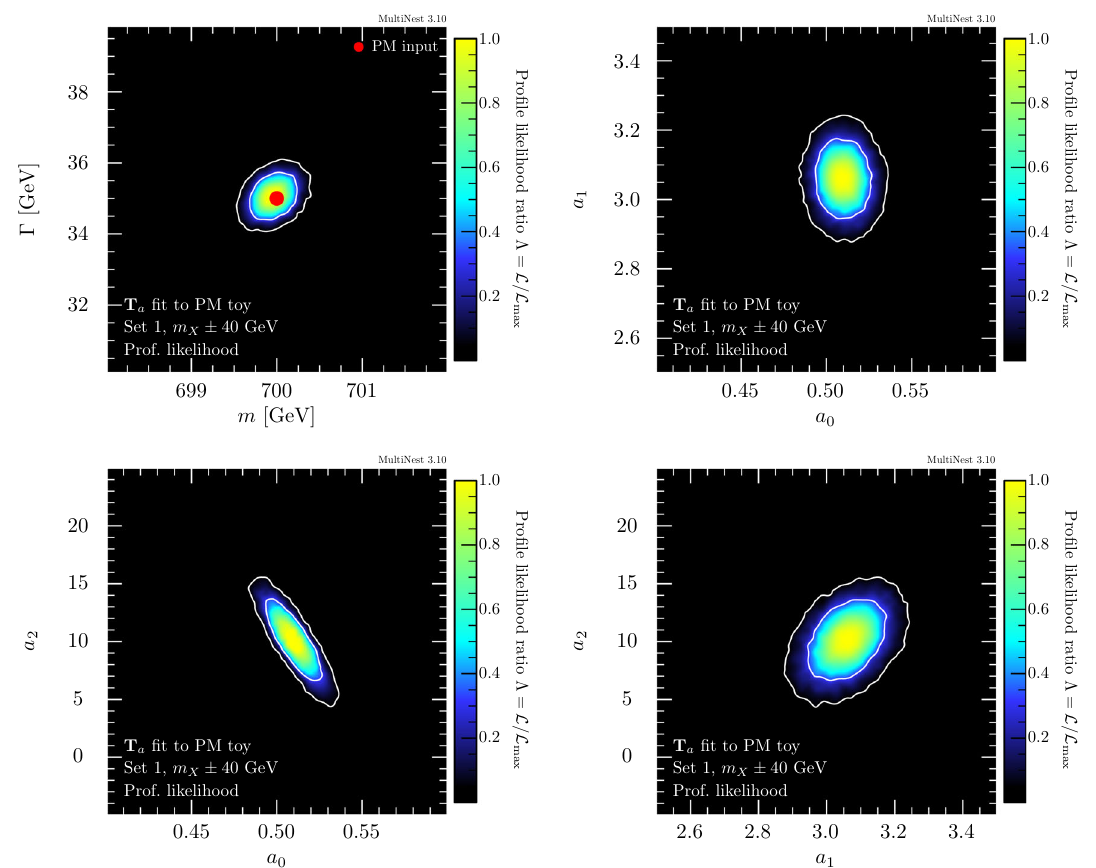
Fig. 7 Fit result for the T a parameters to a PM Asimov toy over the m X ± 40GeV window. The toy corresponds to the m X = 700GeV, (cid:3) / m = 5%, and set 1 input parameters. Two-dimensional profile X X